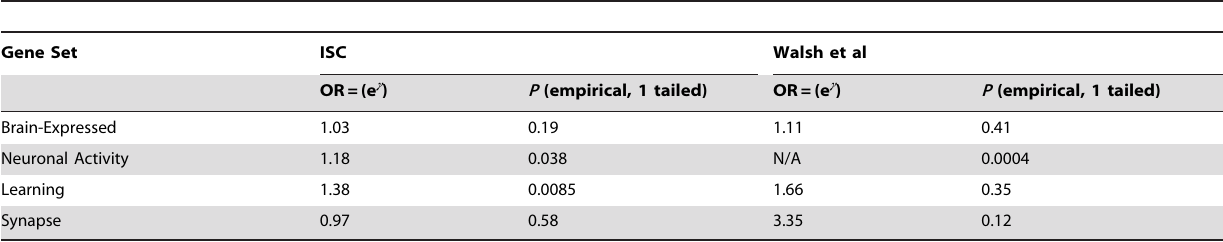
Table 3. Assessing if brain-function genes increase schizophrenia risk in published CNV data sets.